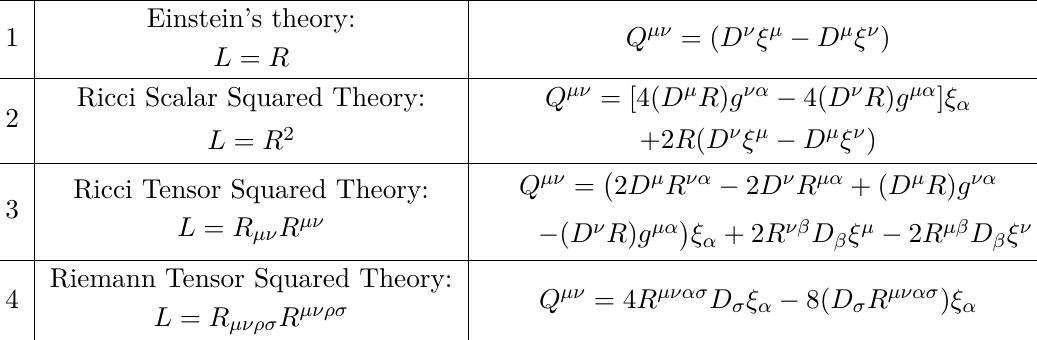
Table 5 . Noether Charges for Einstein gravity and other four derivative theories of